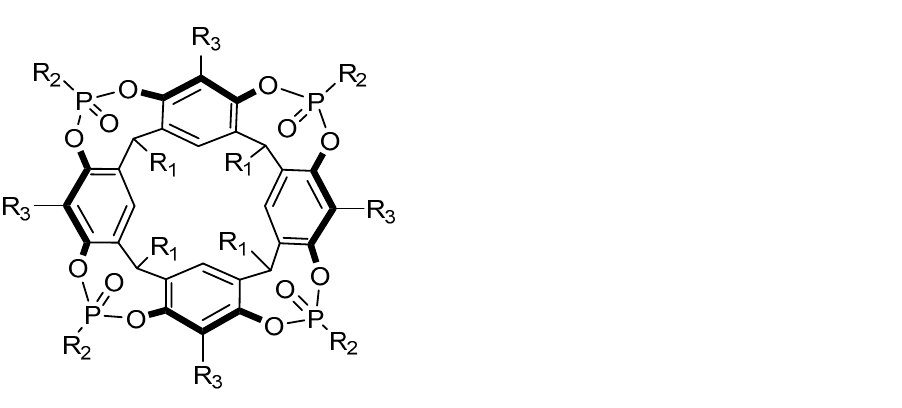
1 ,R 2 ,R 3 ] [113–115].